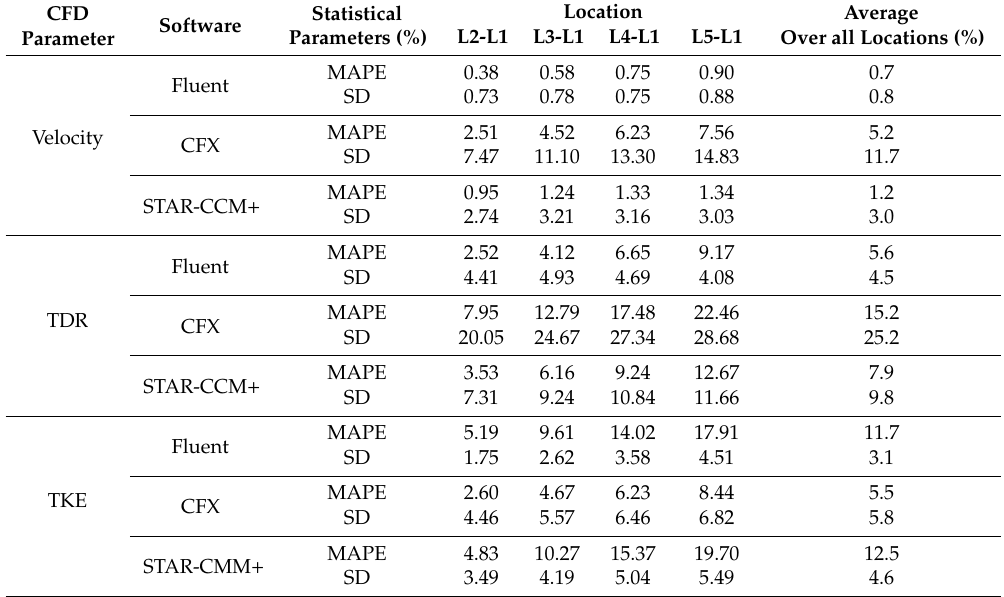
Table 5. Case 1. CFD: Computational fluid Dynamics, TDR: Turbulent Dissipation Rate, TKE: Turbulent Kinetic Energy, and MAPE: Mean Absolute Percentage Error.